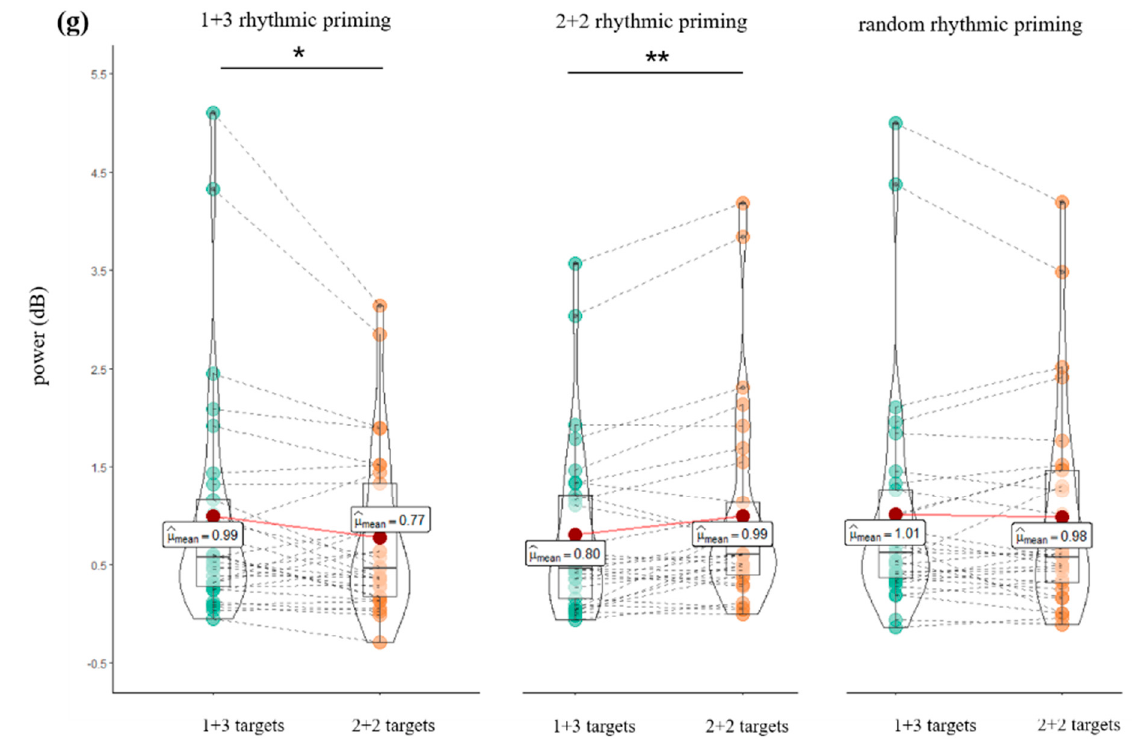
Figure 3. Time–frequency representations (TFRs) of power. ( a , b ) Grand average TFRs for the 2+2 target rhythm ( a ) and 1+3 target rhythm ( b ) under the condition of 1+3 prime rhythm; ( c , d ) grand average TFRs for the 2+2 target rhythm ( a ) and 1+3 target rhythm ( b ) under the condition of 2+2 prime rhythm; ( a , b ) grand average TFRs for the 2+2 target rhythm ( a ) and 1+3 target rhythm ( b ) under the condition of random prime rhythm. All theta power averaged over seven representative frontal channels (showed as white dots in topography). Topographical maps averaged in the time–frequency window of approximately 400–800 ms and 4–8 Hz, as indicated by the red–line–encircled region in each condition. ( g ) The differences in mean theta power averaged in this time–frequency window over frontal channels across all of the participants. The points indicate averages for each participant; dark–red circles represent means; the solid red lines connecting the dark–red circles visually reveal the differences between the mean theta power of different conditions; the dashed gray lines connecting the green or yellow points indicate scores for the same participant; and the boxplots represent the medians and interquartile ranges. * p < 0.05, ** p < 0.01.